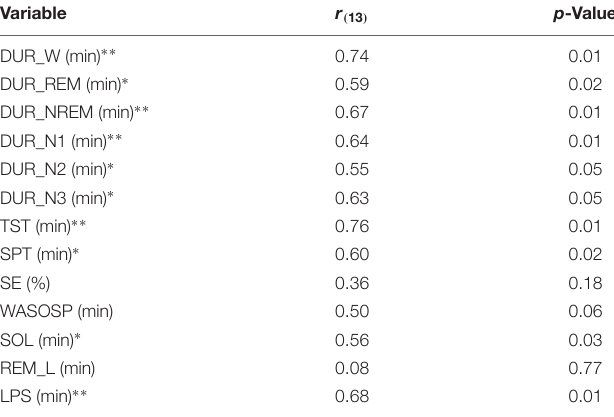
TABLE 3 | Bland Altman statistics for sleep parameters obtained from scorer 1. Sleep parameter